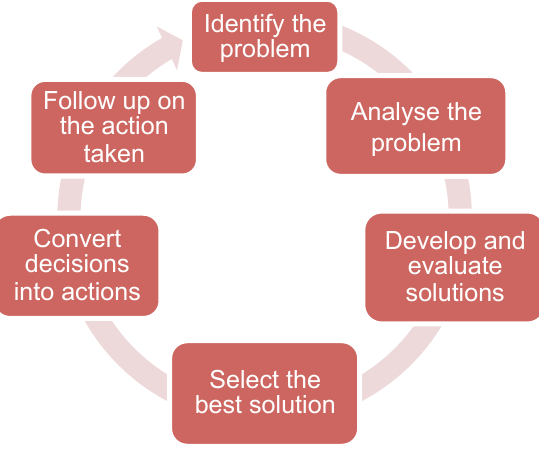
Figure 6. The chain of the decision-making